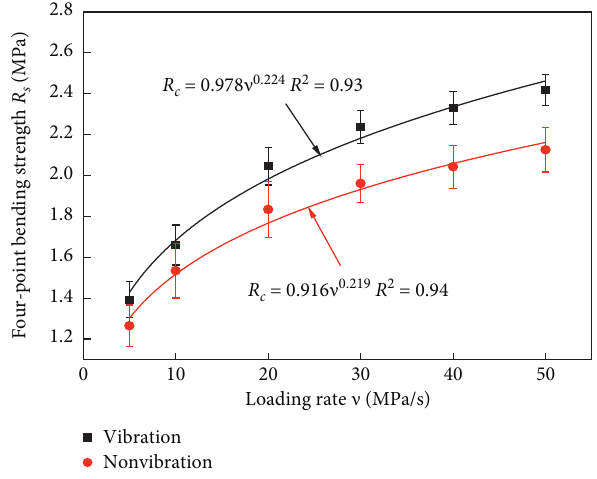
Figure 6: Bending tensile strength of cement-treated aggregates affected by loading